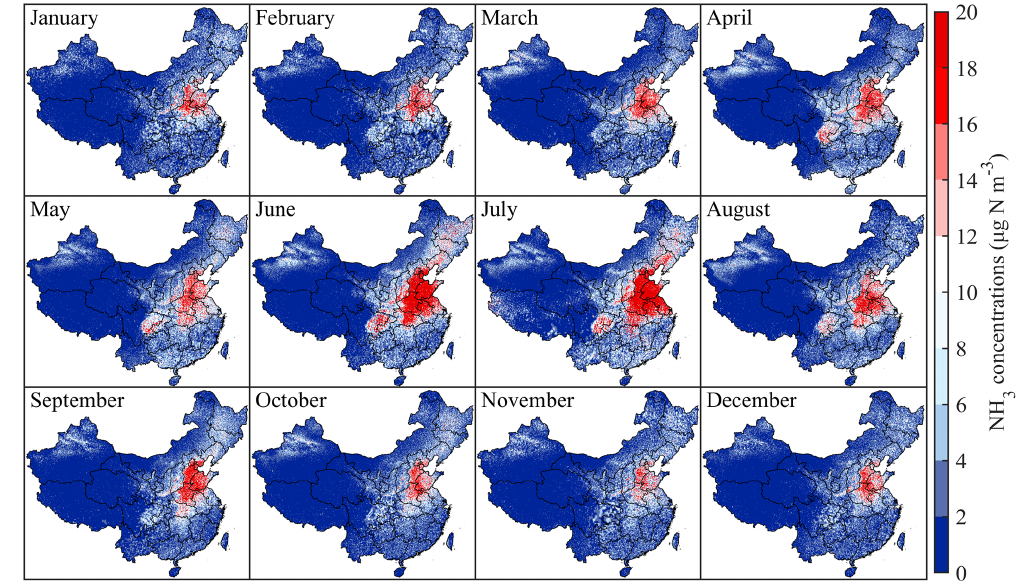
Figure 7. Spatial distribution of monthly surface NH 3 concentrations in China by the IASI in 2019.